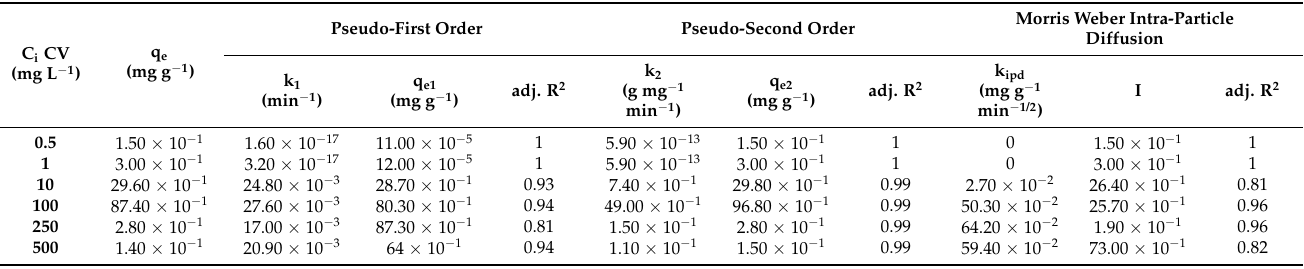
Table 2. Results of the kinetic models for CV adsorption on MNP@PAAA-FA (Ci = 0.5–500 mg L − 1 , 100 mg material, 298 K, 700 rpm).